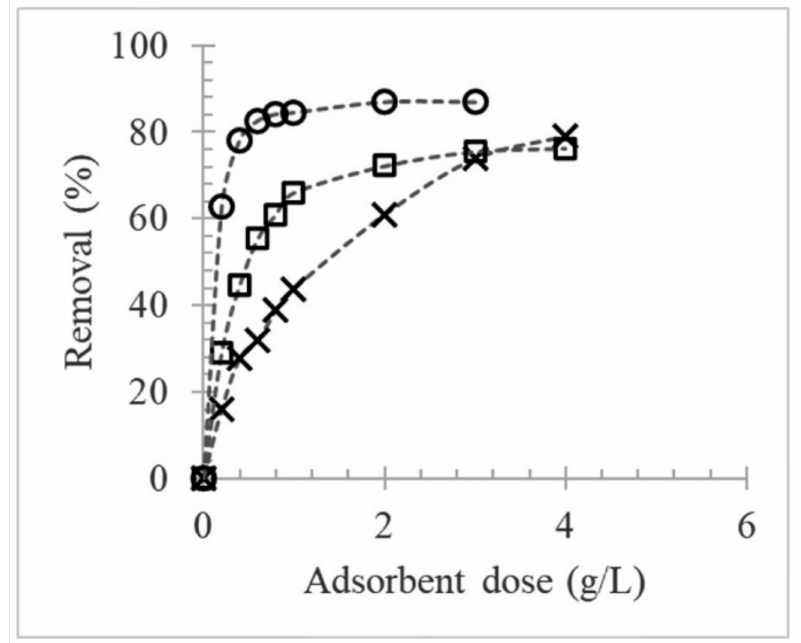
Figure 4. Effect of fining agent dose on removal of polyphenolic compounds from model wine solution with grape skin tannin (0.6 g/L). Legend: PVPP (X); PP ( (cid:3) ); BSA (